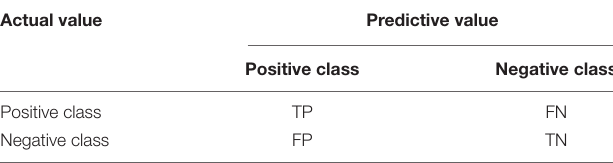
TABLE 3 | Confusion